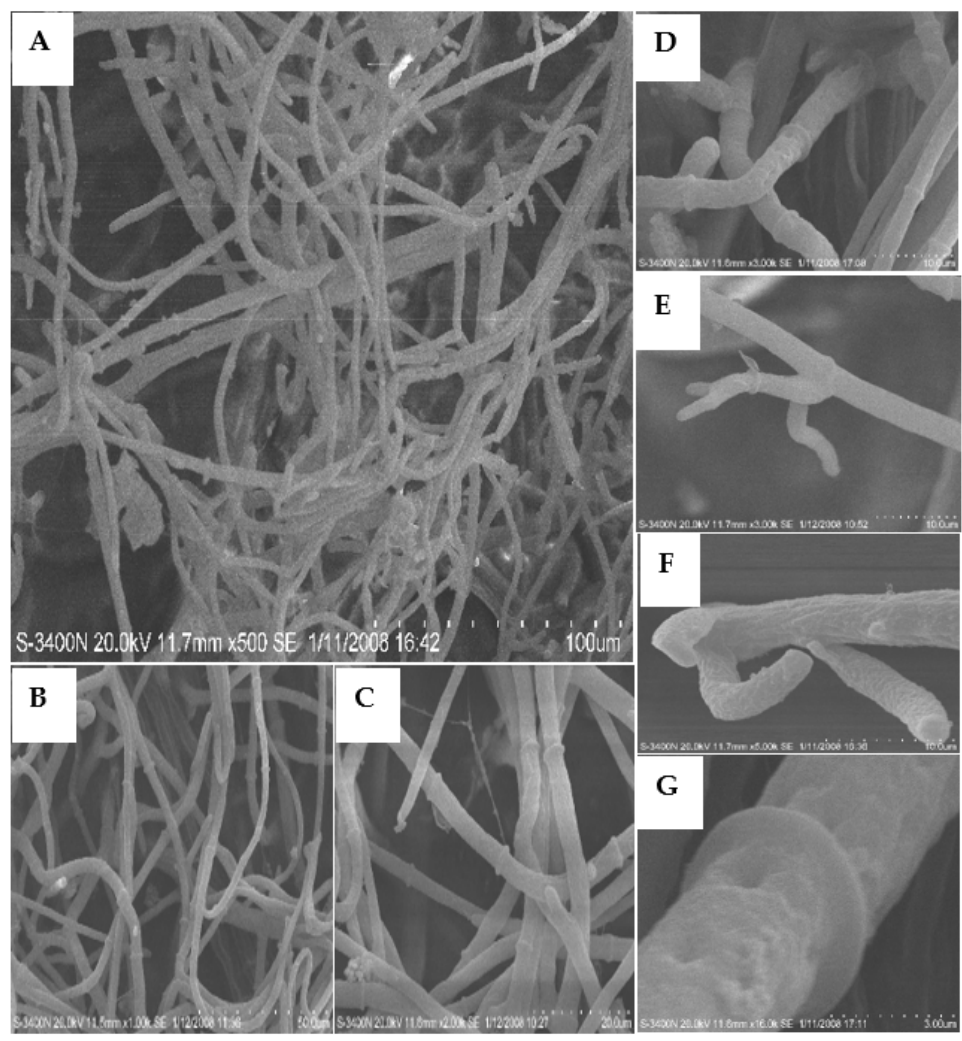
Figure 3. SEM images of the hyphae from the colony of B. cinerea grown on PDA medium with 50 μg/mL of L13 . Scale bars: ( A ) 100.0 μm; ( B ) 50.0 μm; ( C ) 20.0 μm; ( D – F ) 10.0 μm; ( G ) 3.0 μm.